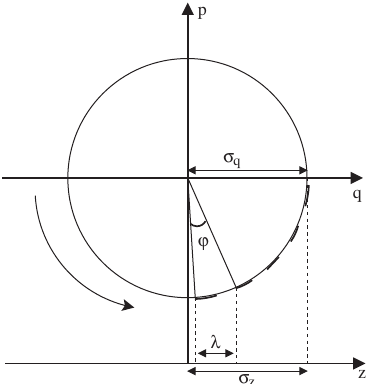
FIG. 3. Schematic representation of an electron-bunch phase space with a modulation located at a distance σ q from the bunch center. The distance λ is associated to the projection on the horizontal axis (in unit of meters) of the arclength corresponding to one modulation period of the phase space. The distance λ is generally associated to a coherent emission, and thus can be measured experimentally.